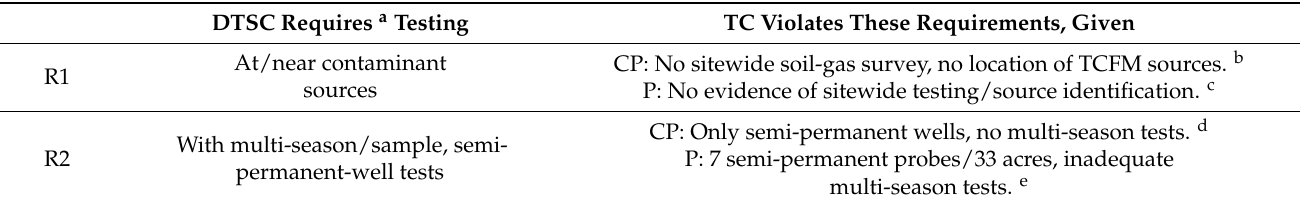
Table 5. Violations of testing requirements, former missile-testing site, Canoga Park, California (CP) and former landfill, Pacoima, California